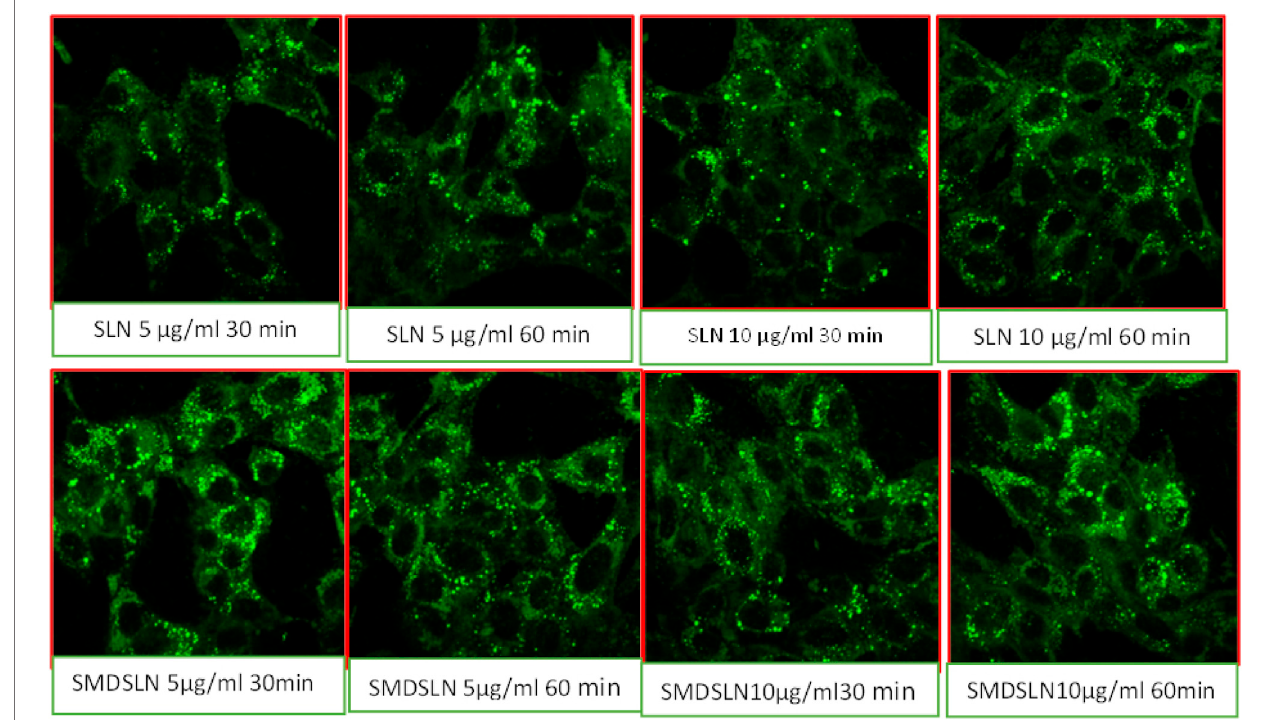
FIGURE 6 | Qualitative cell uptake of developed SLN formulations by confocal microscopy.